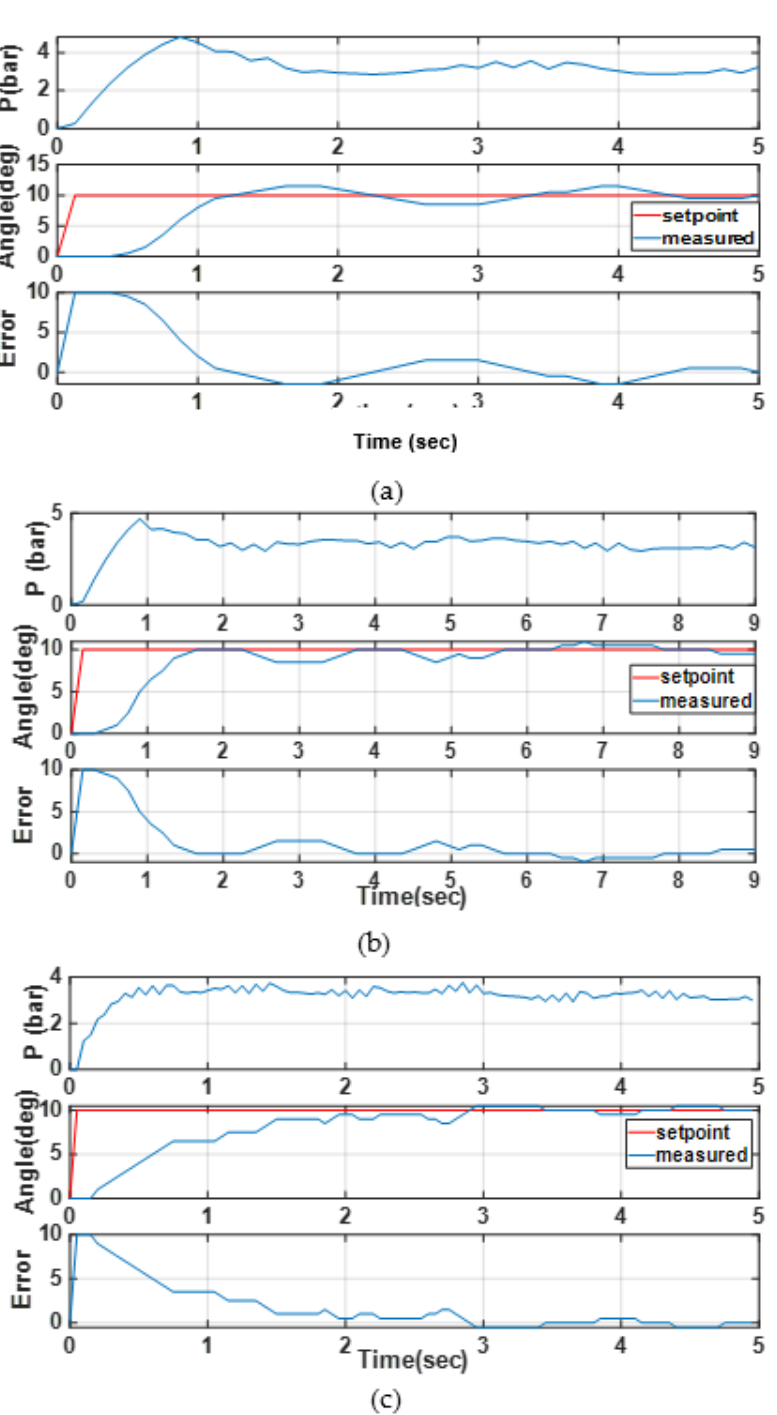
Figure 14. Experimental results of the change of pressure, angle and error with time by using: ( a ) Z.N tuning technique; ( b ) GA tuning technique; ( c ) PSO tuning technique. tuning technique; ( b ) GA tuning technique; ( c ) PSO tuning